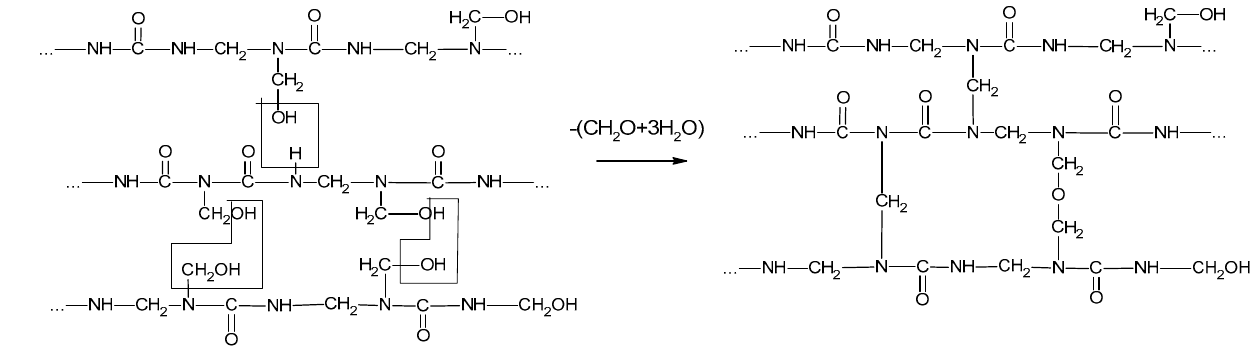
Figure 6. The curing process of urea–formaldehyde resin.